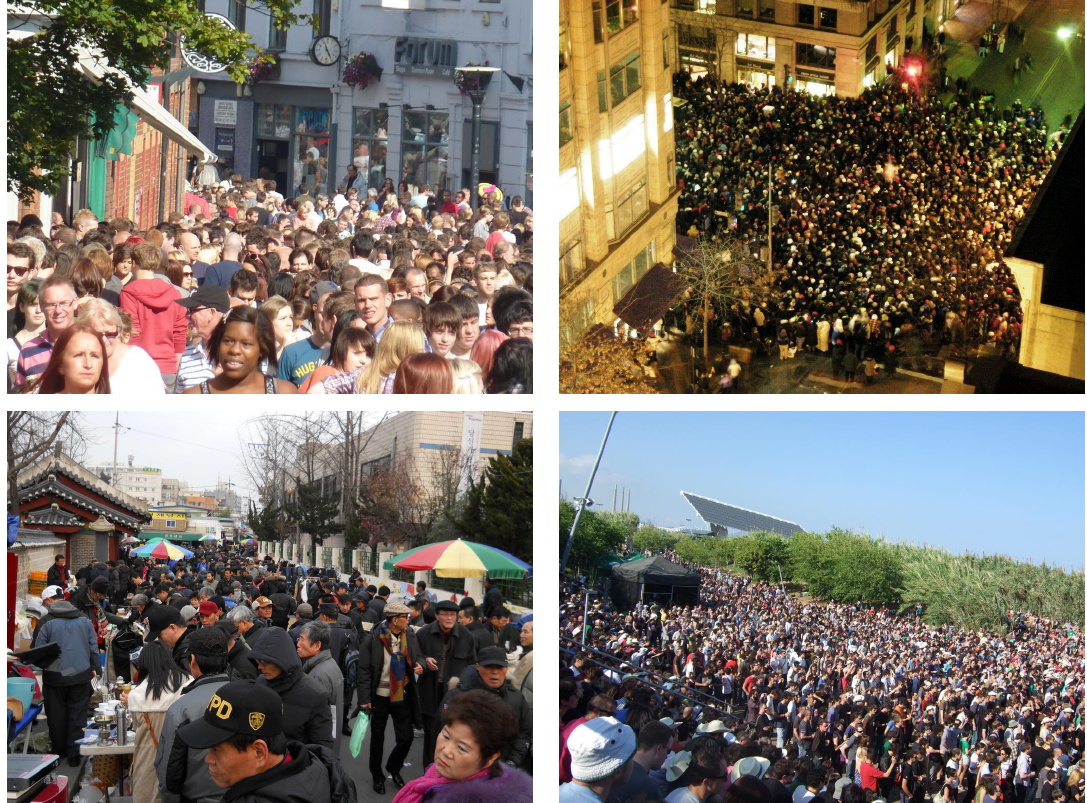
Figure 3. ShanghaiTech part A crowd images